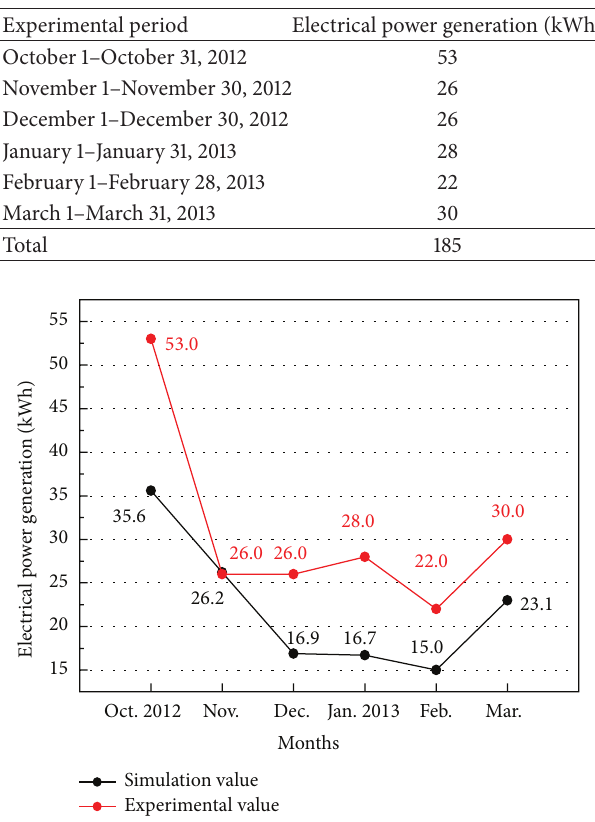
Figure 14: Comparison of electrical generation results from the simulation and